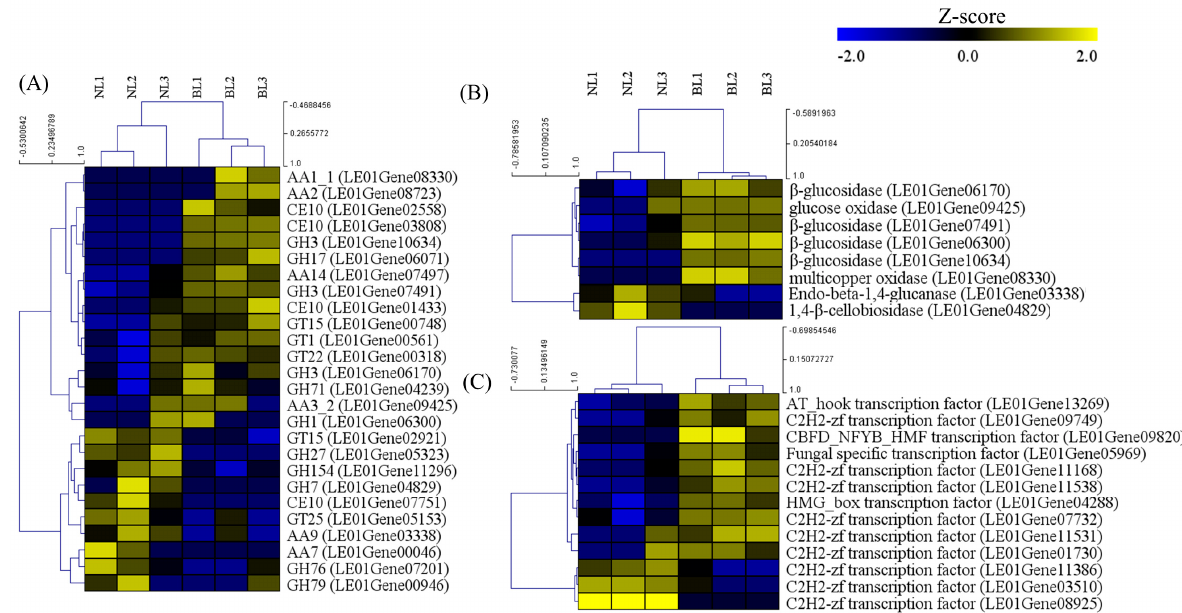
Figure 4. Heat map analysis and hierarchical clustering of up and downregulated genes under blue light and no-light conditions for ( A ) CAZyme, ( B ) lignocellulose, and ( C ) transcription factor. Each column represents an experimental mushroom sample under a different light source (no light and blue light), and each row represents an identified gene. Yellow and blue indicate the upregulation and downregulation of each gene, respectively. Expression values of genes were transformed into Z-score values.